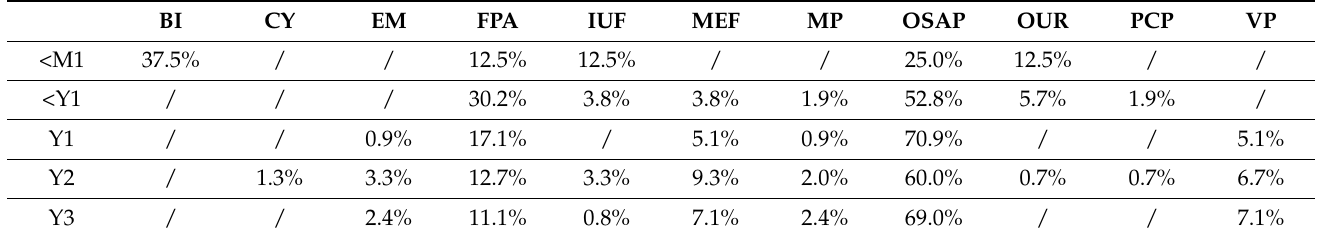
Table 1. The proportion of different causes of injury in all ages of